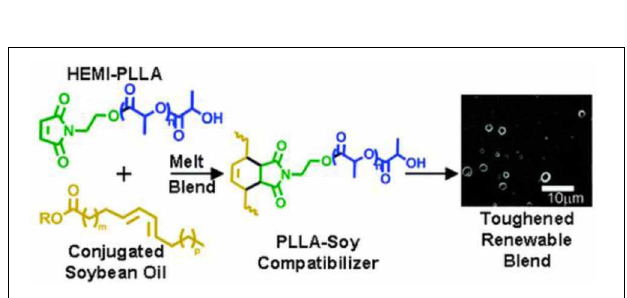
FIGURE 16 | In situ Diels-Alder reaction coupling the two immiscible components HEMI-PLLA and conjugated soybean oil (CS) by means of reactive compatibilization. Adapted with permission from Gramlich et al.